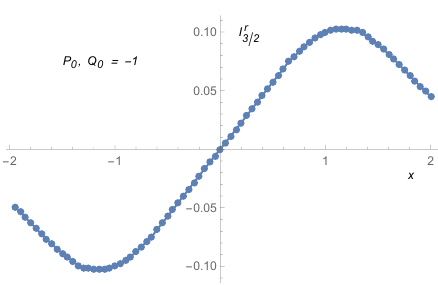
( X ) , for a wave packet in fractional quantum mechanics with Figure 1. Re-scaled extra-current, I r 3/2 α = 3/2 that is moving to the left. The extra-current is equal by definition to the quantity ∂ t ρ + ∇ · j , which vanishes in a theory with local conservation of charge. It can be interpreted in this case as an amount of charge per unit time that disappears from the head of the packet and re-appears in its tail.